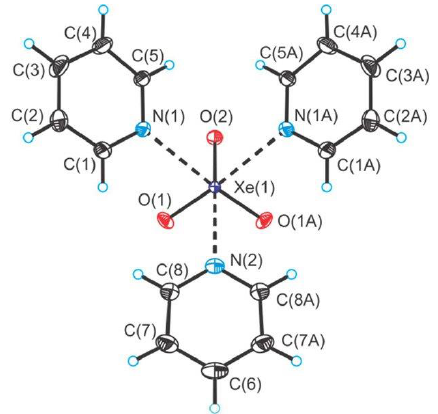
Figure 17. Top-down view of (C 5 H 5 N) 3 XeO 3 in the X-ray crystal structure of (C 5 H 5 N) 3 XeO 3 . Copyright (2018) Elsevier. Used with permission from Ref. [43].